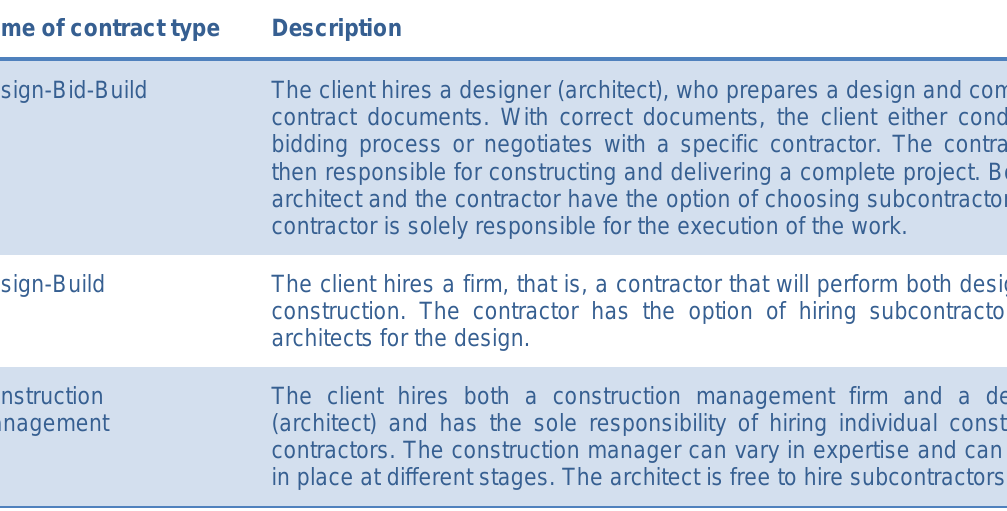
Table 1: Contracts structure in Gould and Joyce (2011, Ch. 4)